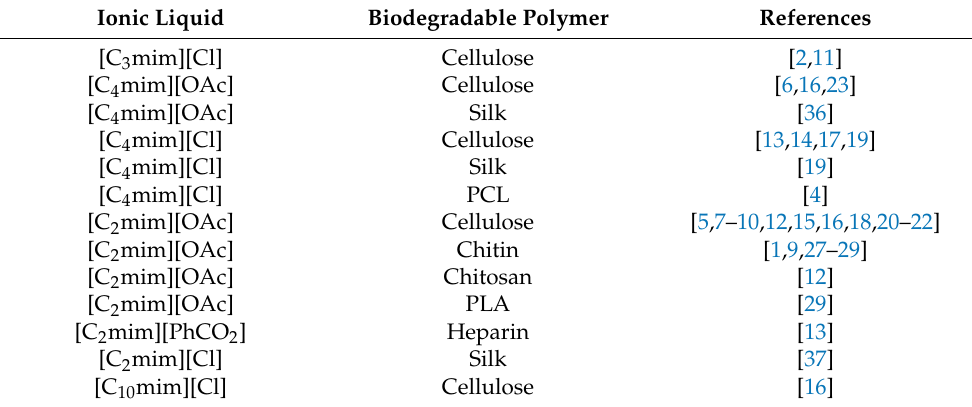
Table 3. Examples of ionic liquids utilized as solvents for electrospinning of biodegradable